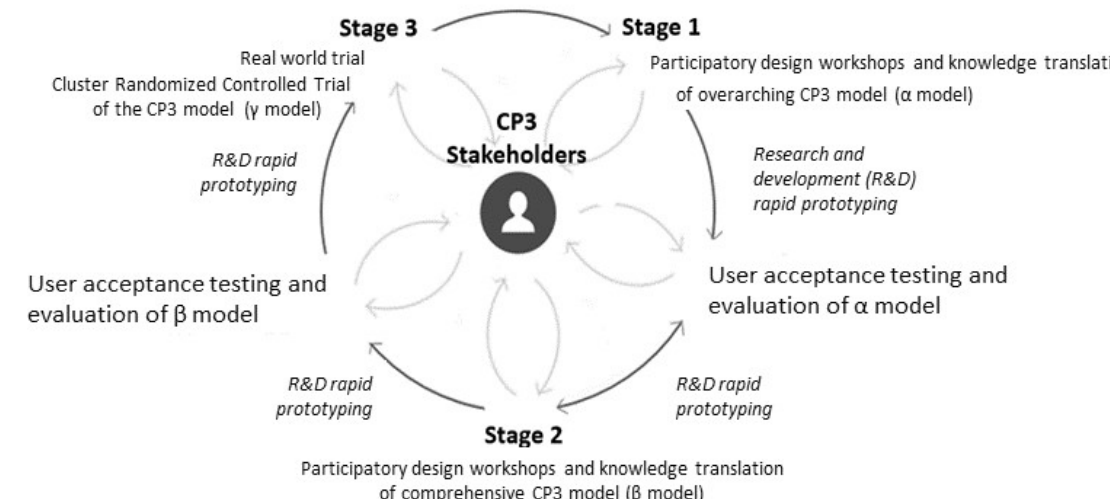
Figure 1. Connect, promote, and protect program research and development cycle. CP3: connect, promote, and protect program; R&D: research and